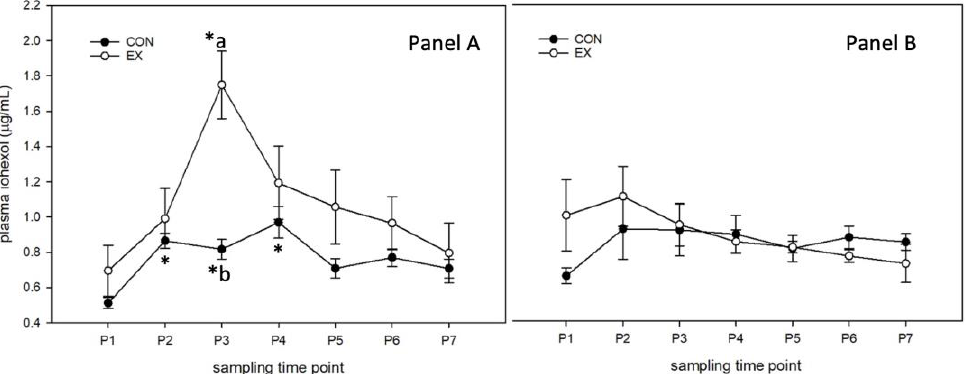
Figure 2. Plasma iohexol ( µ g/mL). Horses (n = 8) on the SUPP diet were administered an oral dose of iohexol (5.6% solution; 1 mL/kg BW) immediately prior to one hour of trailer transport followed by 30 min of moderate-intensity exercise (EX) prior to supplementation (Panel A ) and after 28 days of supplementation (Panel B ). Unstressed horses (SED; n = 8) were maintained in stalls as controls and sampled at the same time intervals. Blood was sampled prior to iohexol administration (P1), immediately after trailering (P2), immediately after exercise (P3), and 1 (P4), 2 (P5), 4 (P6), and 8 h post-exercise (P7). * denotes significant change from baseline within a group; different letters denote significant differences between groups at a given time point.